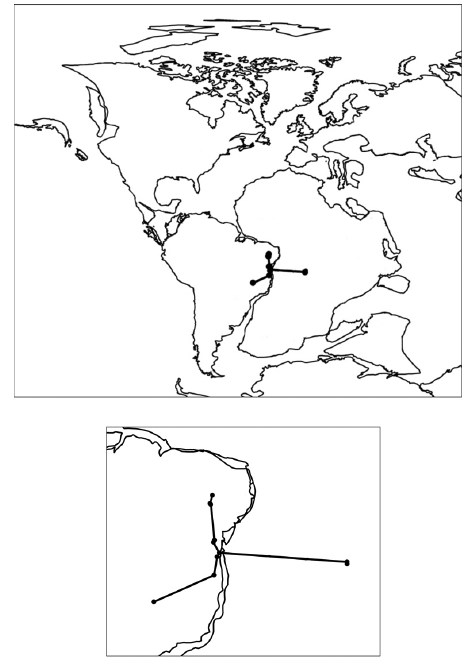
Fig. 6 - kimmeridgian paleogeographic map showing the indi- vidual track of Rhipis moorseli , with a zoom of the occurrences below.